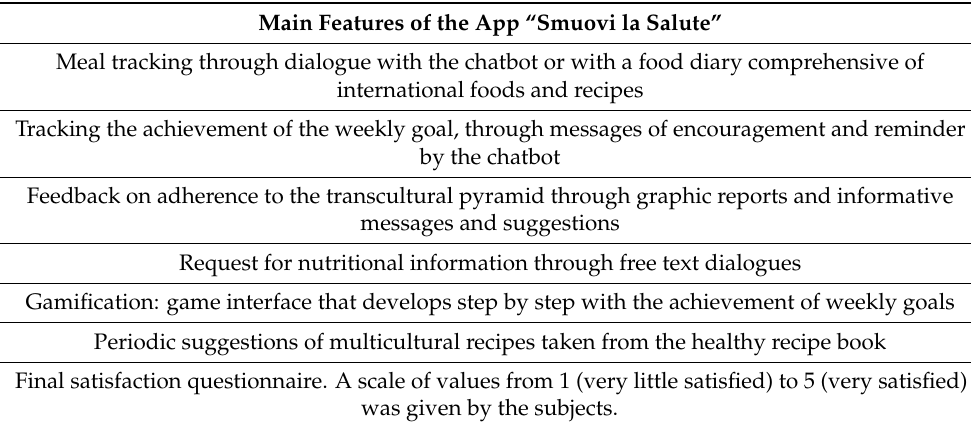
Table 1. Main features of the app “Smuovi la Salute”. Main Features of the App “Smuovi la Salute” Meal tracking through dialogue with the chatbot or with a food diary comprehensive of international foods and